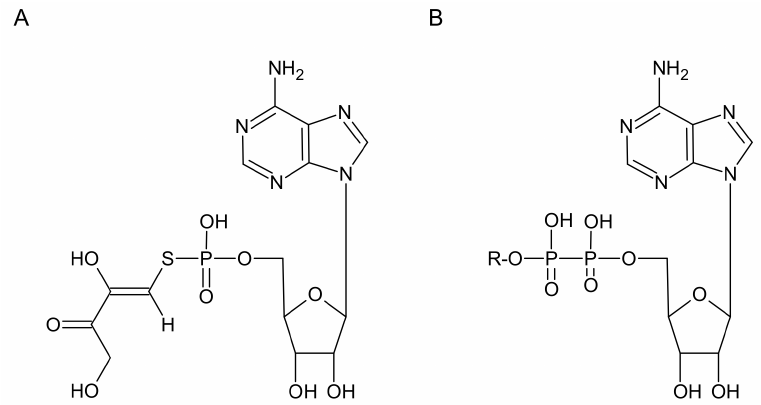
Figure 1. The structure of the the reactive adenosine derivative, adenosine 5 (cid:48) - O -[ S -(4-hydroxy- 2,3-dioxobutyl)]-thiophosphate (AMPS-HDB) ( A ). The structure of the ADP part of NAD + is also presented ( B ), for comparison. Where R: nicotinamide ribose part of NAD +